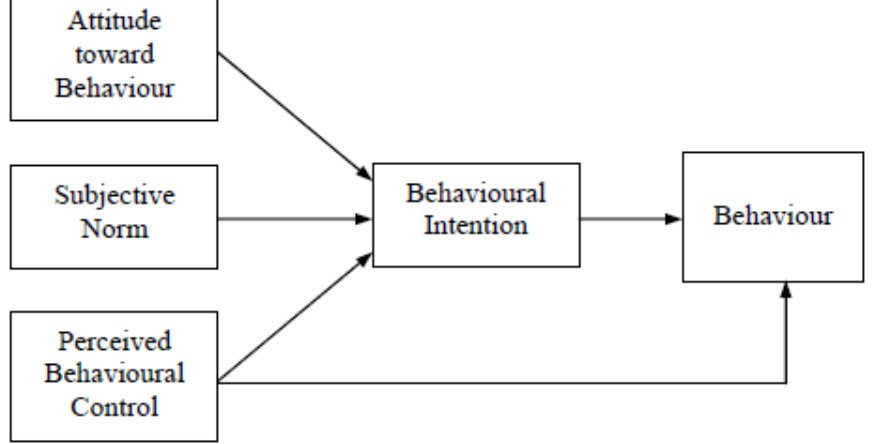
Figure 1. The theory of planned behavior (Ajzen,